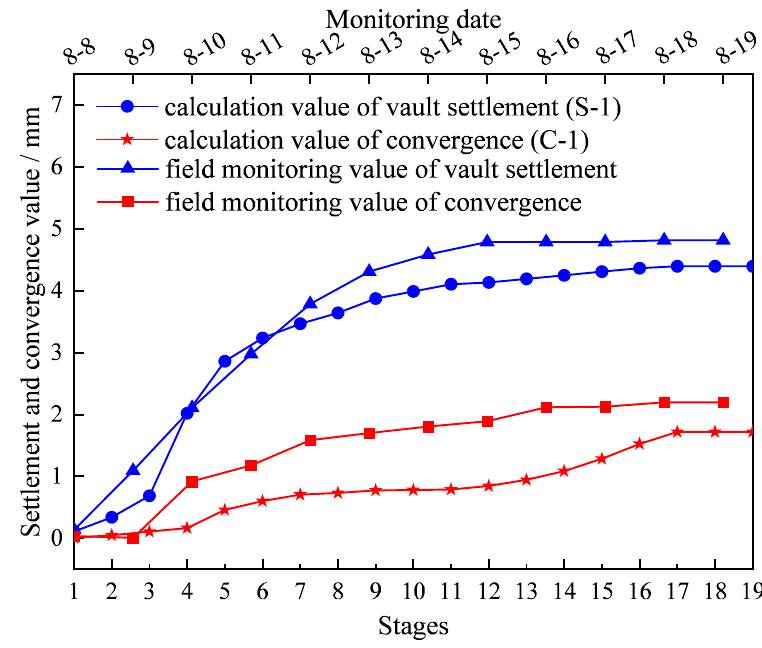
Figure 10. Displacement comparison between monitoring value and calculation value.